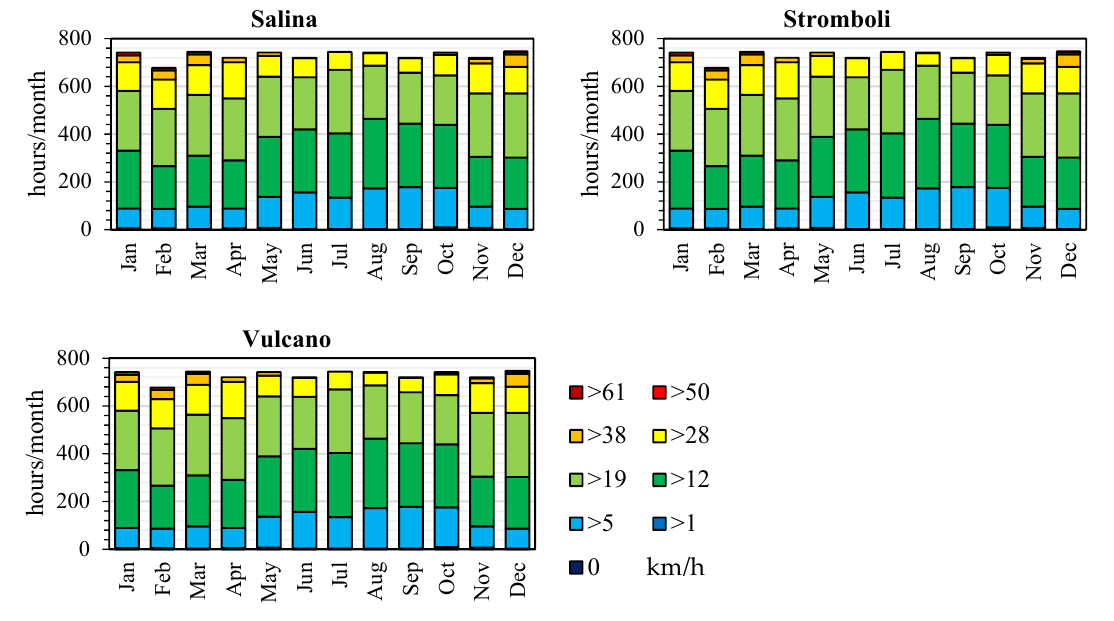
Figure A2. Availability of wind source for each island during the year.